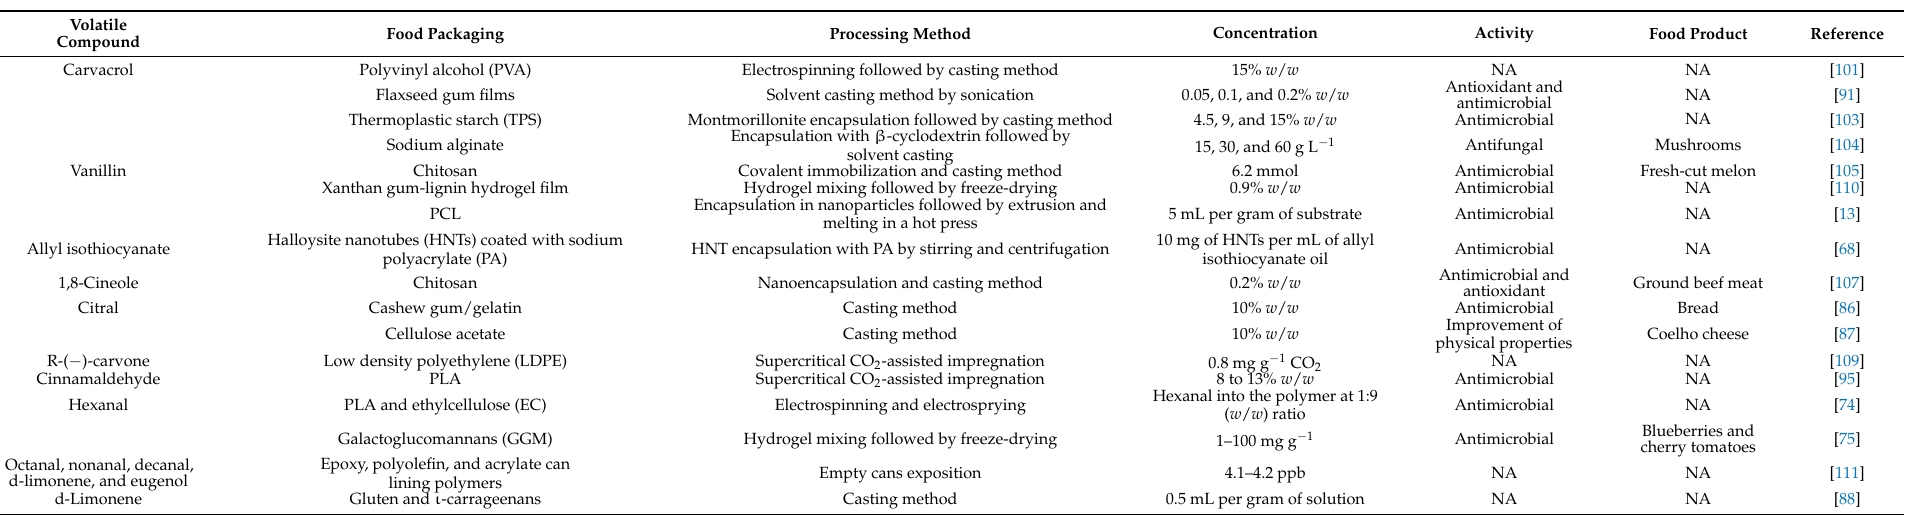
Table 3. Current applications of minor volatile compounds used in food packaging. NA: not